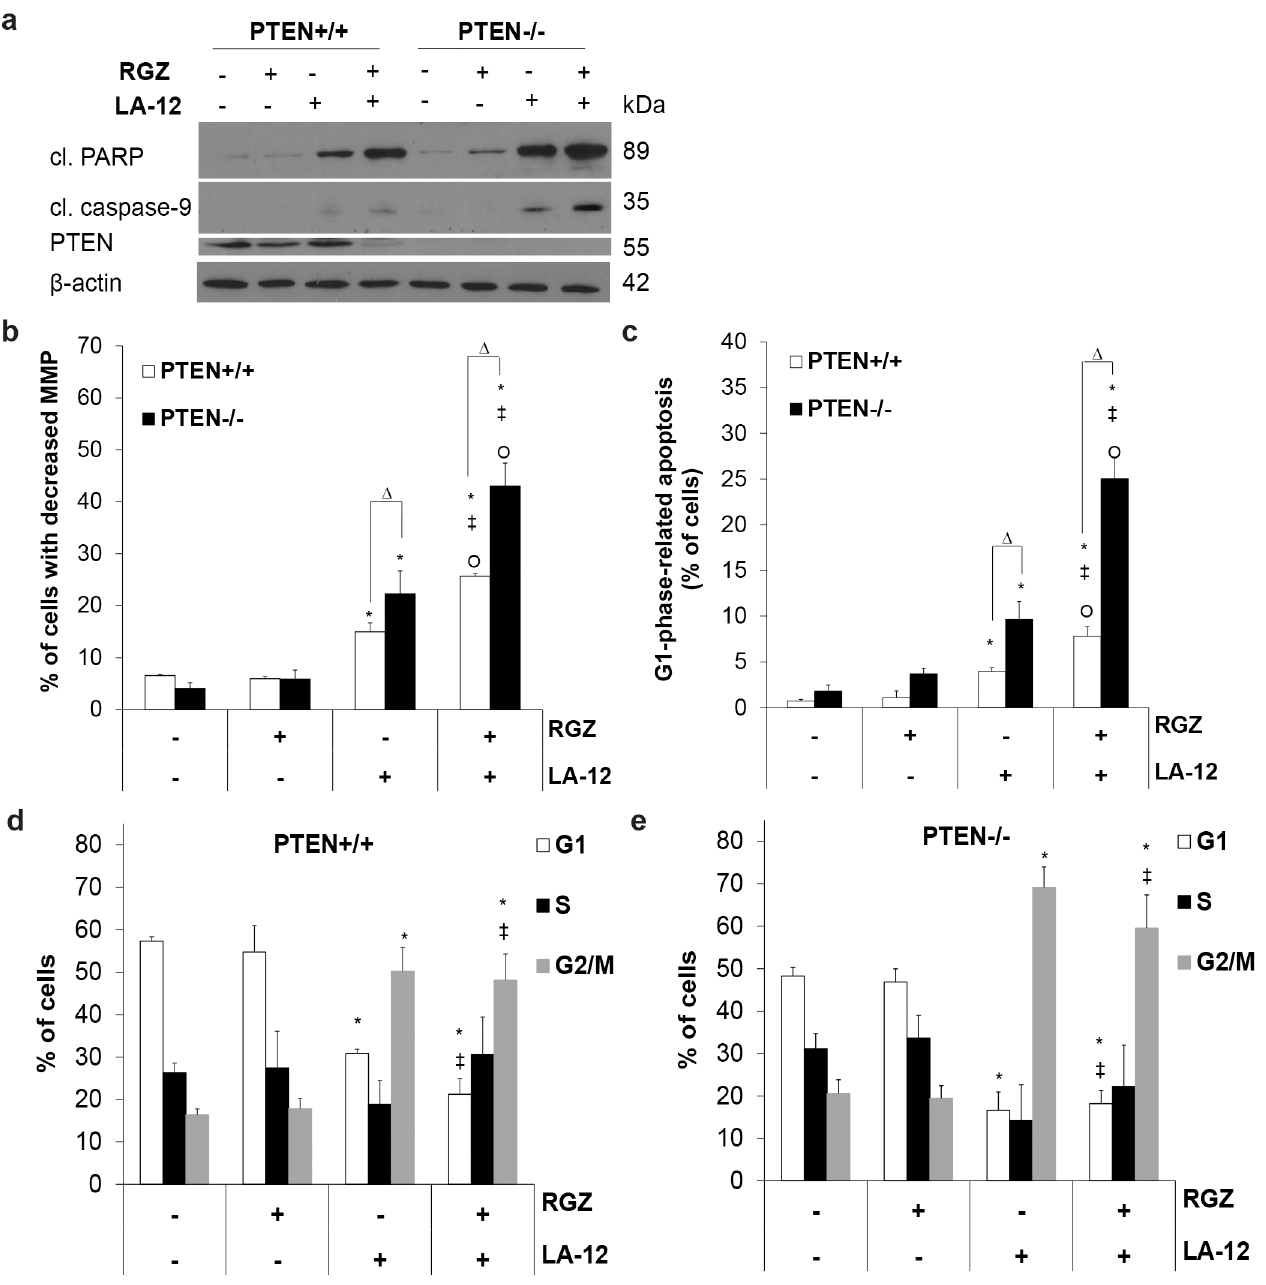
Fig 5. A functional importance of PTEN in rosiglitazone-mediated sensitization of HCT116 cells to LA-12-induced apoptosis. (a) Cleavage of PARP, caspase-9 and PTEN level (Western blotting), (b) changes in mitochondrial membrane potential (MMP, flow cytometry), and (c) percentage of apoptotic cells (with active caspase-3) in G1 cell cycle phase in HCT116 wt or PTEN-/- cells pretreated (24 h) with rosiglitazone (RGZ, 50 μ M), and subsequently treated (48 h) with LA-12 (0.75 μ M). (d, e) Percentage of HCT116 wt and PTEN-/- cells in individual cell cycle phases (flow cytometry) following the treatments specified in a-c). Results are means + S.E.M. or representatives of three independent experiments. Statistical significance: P < 0.05, * versus control, ‡ versus RGZ, Ο versus LA-12, and Δ for wt versus PTEN-/-